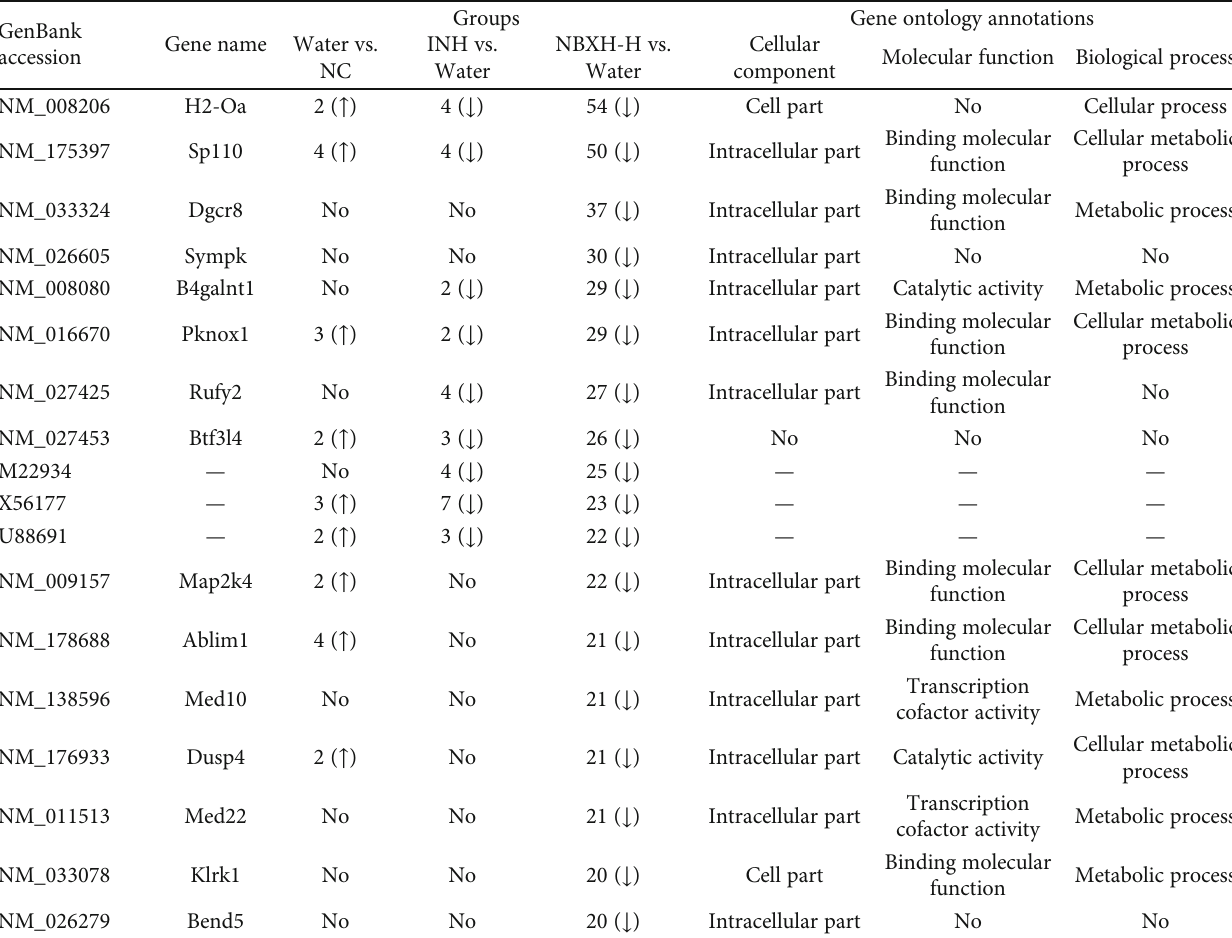
Table 4: The signi fi cant downregulated genes after NBXH-H